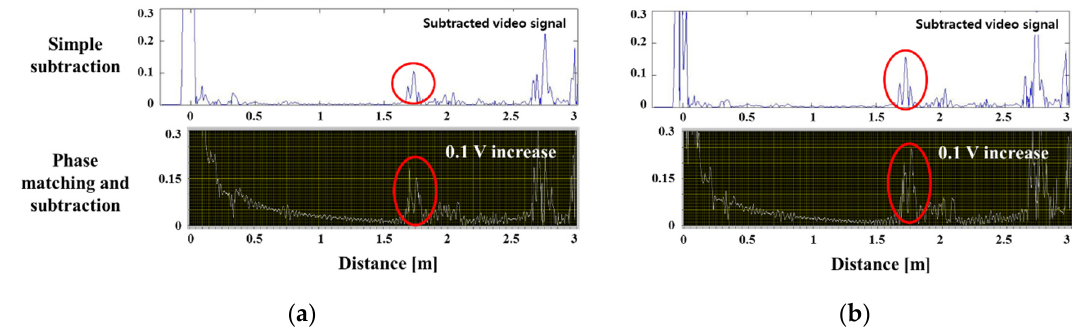
Figure 11. Comparison between simple elimination and phase matching-subtraction; signals of corrosion in a pipe weld: ( a ) defect ratio 2.55%, ( b ) defect ratio 3.46%. corrosion in a pipe weld: ( a ) defect ratio 2.55%, ( b ) defect ratio